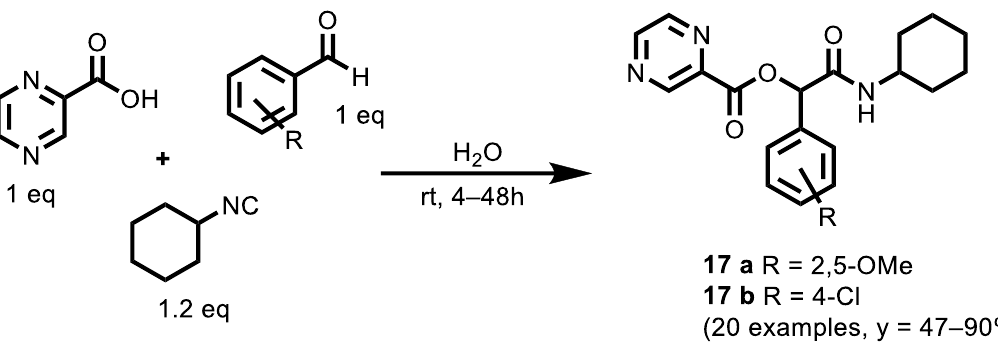
Scheme 5. Three- Component Passerini Synthesis of α -acyloxyamides.